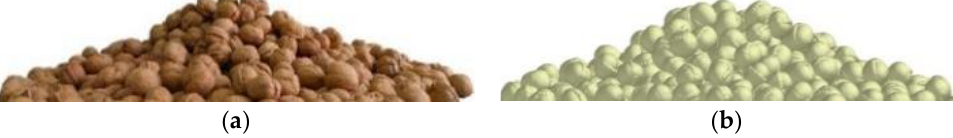
Figure 9. Comparison between simulation results and physical test results of stacking angle. ( a ) Physical test; ( b ) Simulation test.